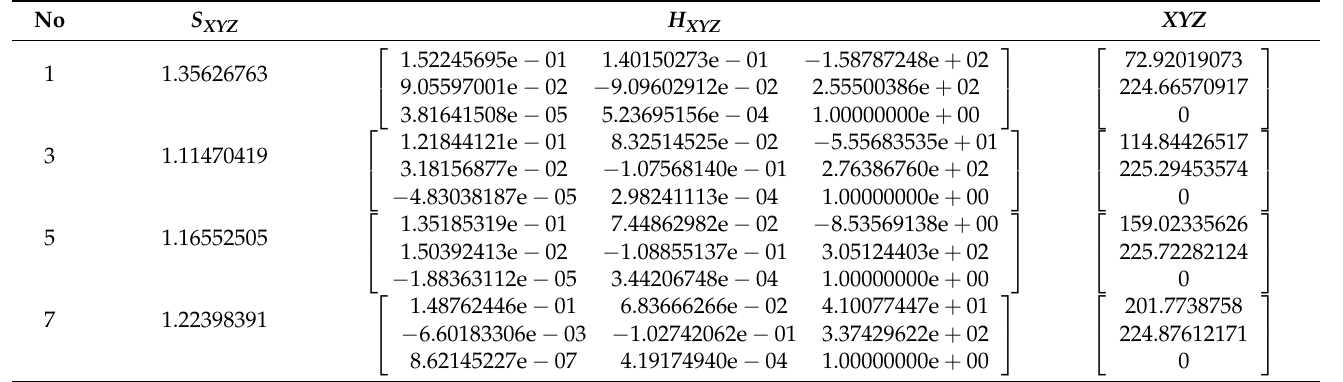
Table 4. Calculation results of target’s coordinates of horizontal